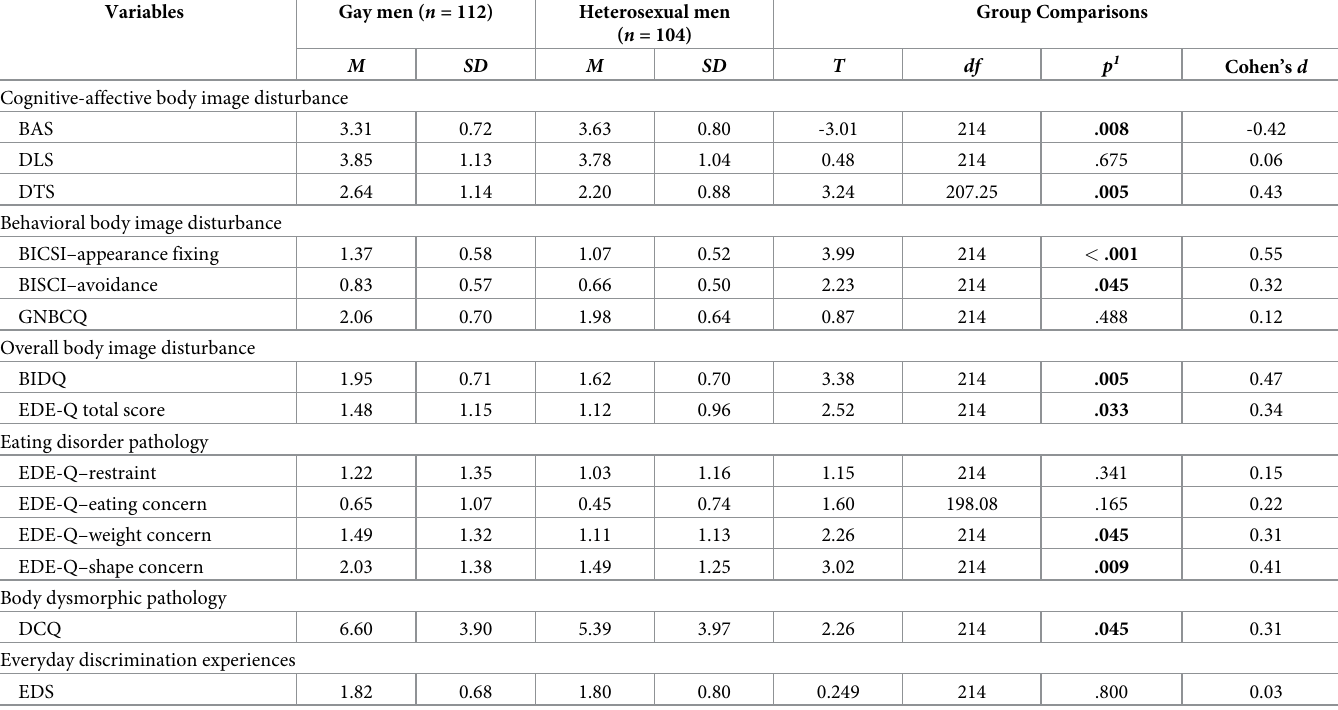
Table 2. Group comparisons regarding body image disturbance facets, eating disorder and body dysmorphic disorder pathology, and everyday discrimination experiences.